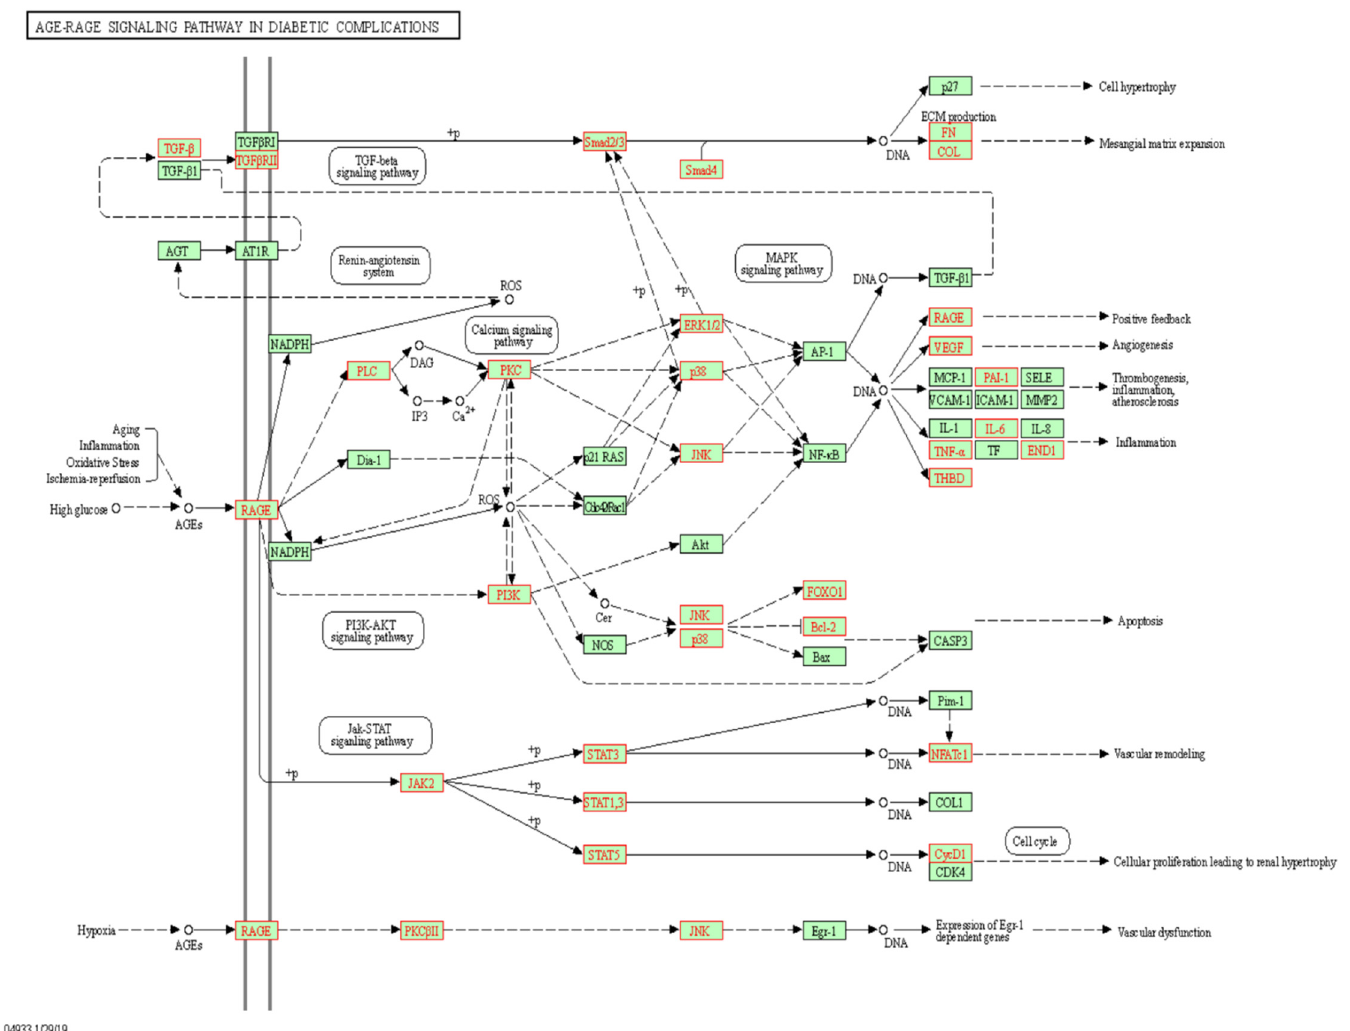
Figure 4. Cis e-QTL genes with trans-meQTL effects on cg19693031 identified in AGE-RAGE signaling in diabetic complications. Cis e-QTL genes with meQTL effects on cg19693031 methylation are highlighted in red ( n = 34).